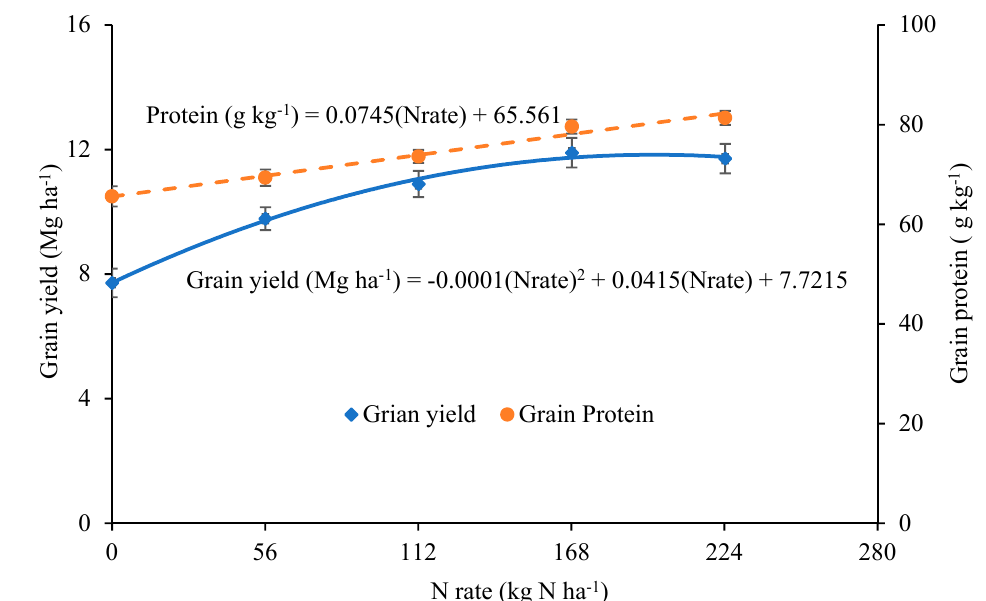
Figure 1. The response of maize grain yield and grain protein concentration to nitrogen fertilizer application rate when data combined over years (2019 and 2020) and N fertilizer application time at Swan Lake Research Farm, near Morris, MN. Error bars are standard errors of the means. Table 4. The effect of N application rate on maize test weight, harvest index, thousand kernel weight (TKW), plant height, ear length and ear diameter when data analyzed over years (2019 and 2020) and N fertilizer application time at Swan Lake Research Farm, near Morris, MN.